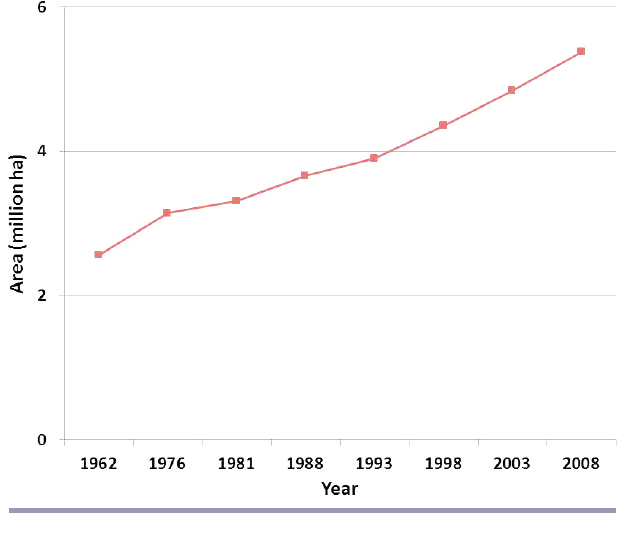
Fig. 2 . Evolution of bamboo total area in China (National Bureau of Statistics of China, several years).